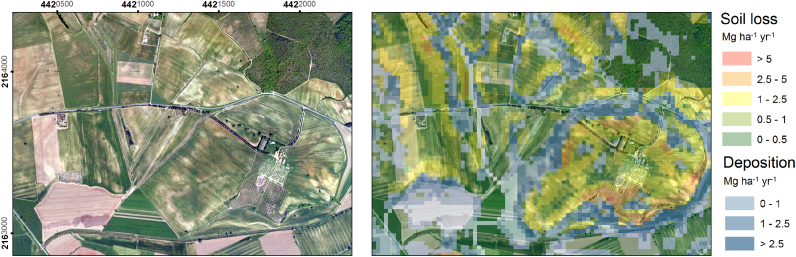
WaTEM/SEDEM results in hilly arable lands ongoing soil erosion and degradation processes in the Southern Tuscany (Magliano, 4421500 N − 2163500E).